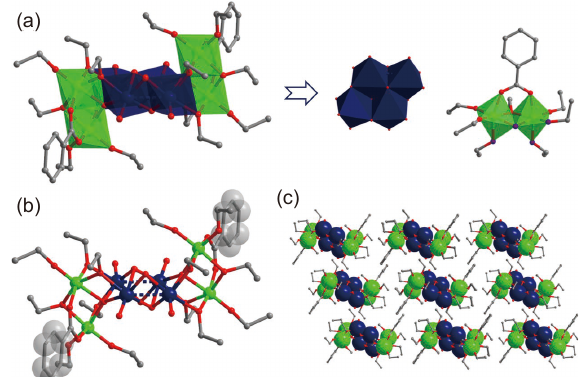
Figure 2 Molecular structures of 2 in (a) polyhedral and (b) ball stick models, respectively. (d) Packing view of 2 along the b-axis. Color code: green: Ti; navy: